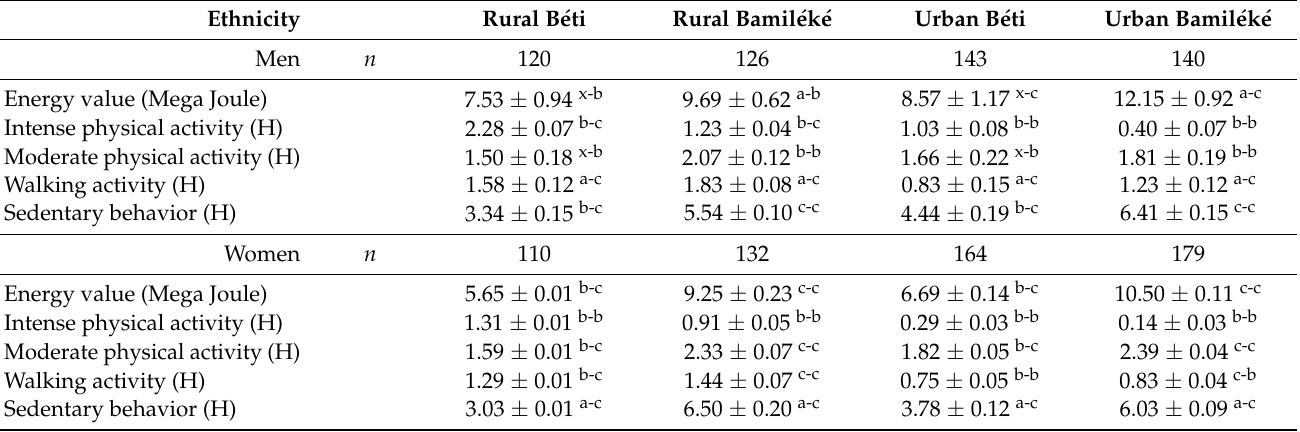
Table 2. Energy values from 24-h recall and physical activity means between B é ti and Bamil é k é in rural and urban areas 1